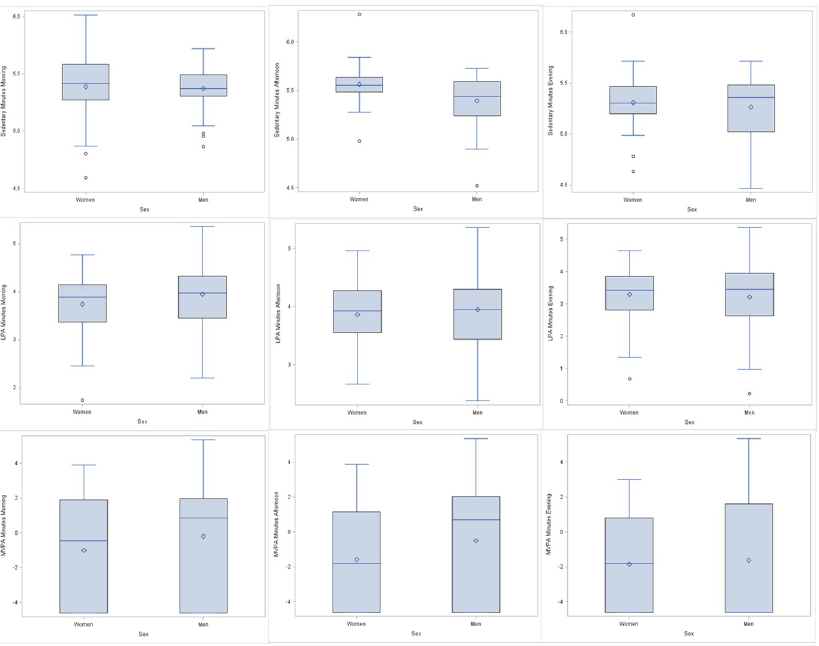
Fig 1. � Distribution of mean minutes per day of a) sedentary time and b) LPA and c) MVPA at various times of the day by sex (transformed data). � Repeated Measures